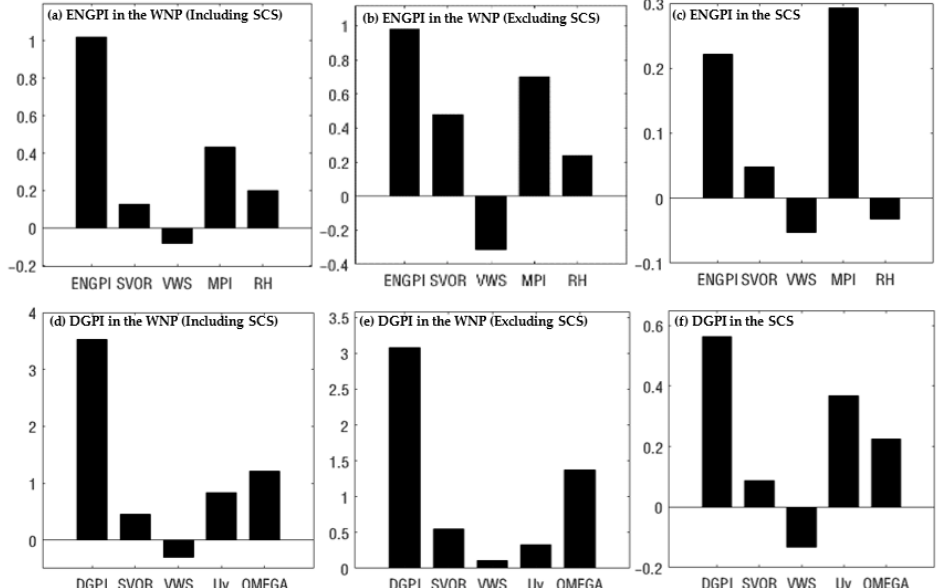
Figure 7. Differences of the GPI (the years with high TC frequency minus the years with low TC frequency) and varying variables over different sea areas: total ENGPI anomaly and the ENGPI anomaly varying absolute vorticity (SVOR), vertical wind shear (VWS), maximum potential intensity ( MPI ), and 600 hPa relative humidity (RH) in the WNP (including SCS) ( a ), the WNP (excluding SCS) ( b ), and the SCS ( c ); Total DGPI anomaly and the DGPI anomaly varying absolute vorticity (SVOR), vertical wind shear (VWS), meridional gradient of zonal wind (Uy), and vertical velocity (OMEGA) in the WNP (including SCS) ( d ), the WNP (excluding SCS) ( e ), and the SCS ( f